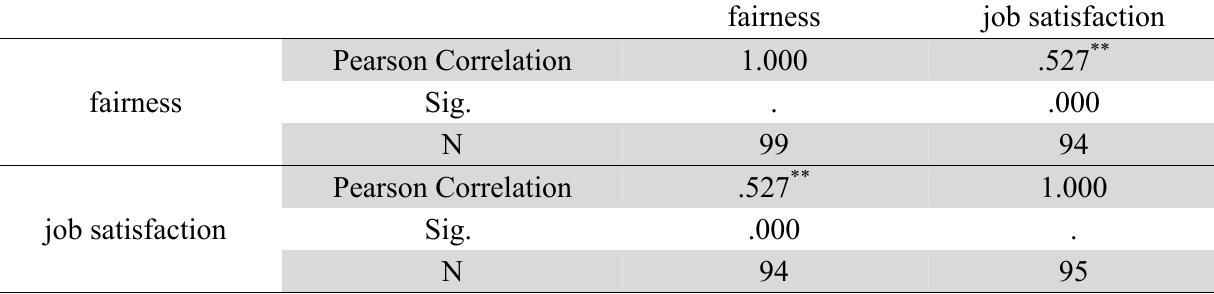
fairness job satisfaction